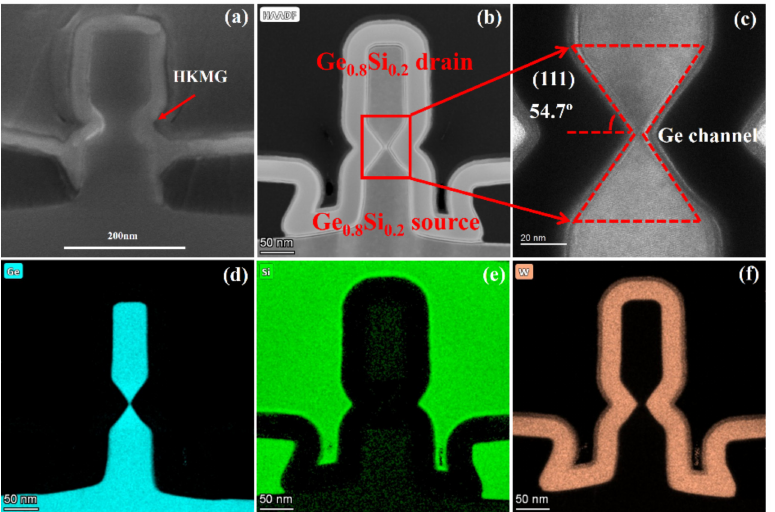
Figure 12. ( a ) SEM and ( b ) TEM images of Ge pVSAFET with gate gaps filling high-k metal gate (HKMG). ( c ) The self-saturated dual-selective etch of Ge at (111) planes result in an hourglass shape with a lateral angle of 54.7 ◦ . Energy-dispersive Xray spectroscopy (EDX) mapping of ( d ) Ge (cyan), ( e ) Si (cyan), and ( f ) W (yellow) atoms with sharp contours.